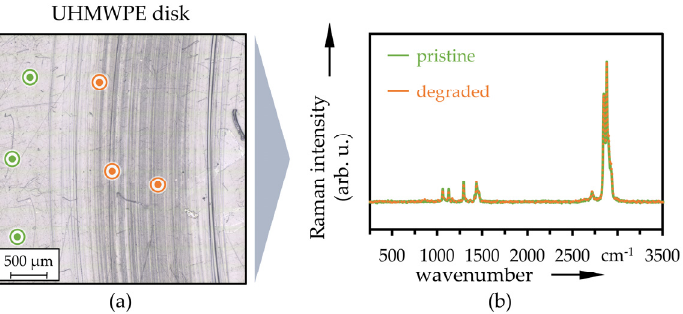
Figure 9. LM image with Raman measurement positions ( a ) and averaged Raman spectra ( b ) at pristine and degraded positions of the UHMWPE disk after sliding against the CoCr pin ( n = 3).